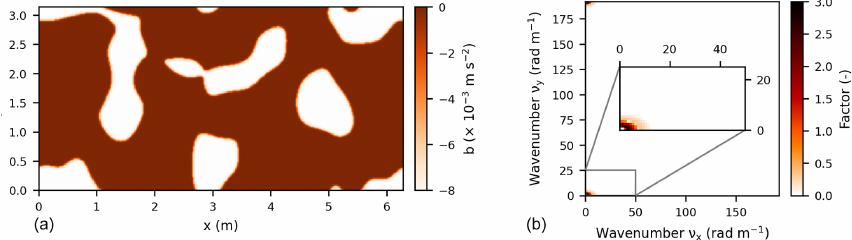
Figure B3. Generated surface temperature and the applied Fourier space in absolute form for the P60m simulation. The generated surface temperature (a) was obtained by applying the inverse fast Fourier transform in Fourier space (b)